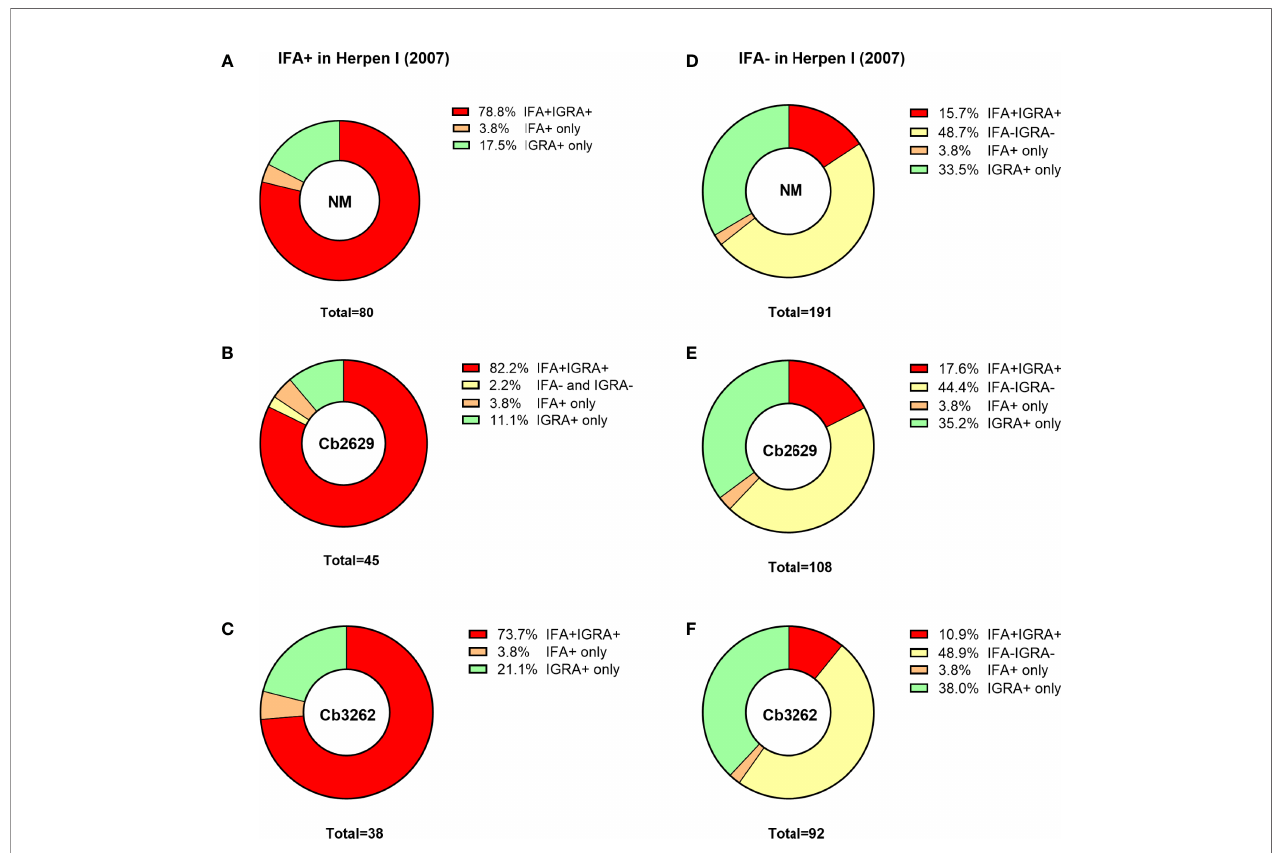
FIGURE 4 | IGRA and IFA results in individuals with known prior Q fever serology status in 2007. The proportion of individuals that scored positive or negative by IFA and IGRA in 2014 [shown separately for Nine Mile (A, D) , Cb2629 (B, E) and Cb3262 (C, F) ] was analyzed for individuals with known prior IFA status (IFA+ A-C; IFA- D-F) in